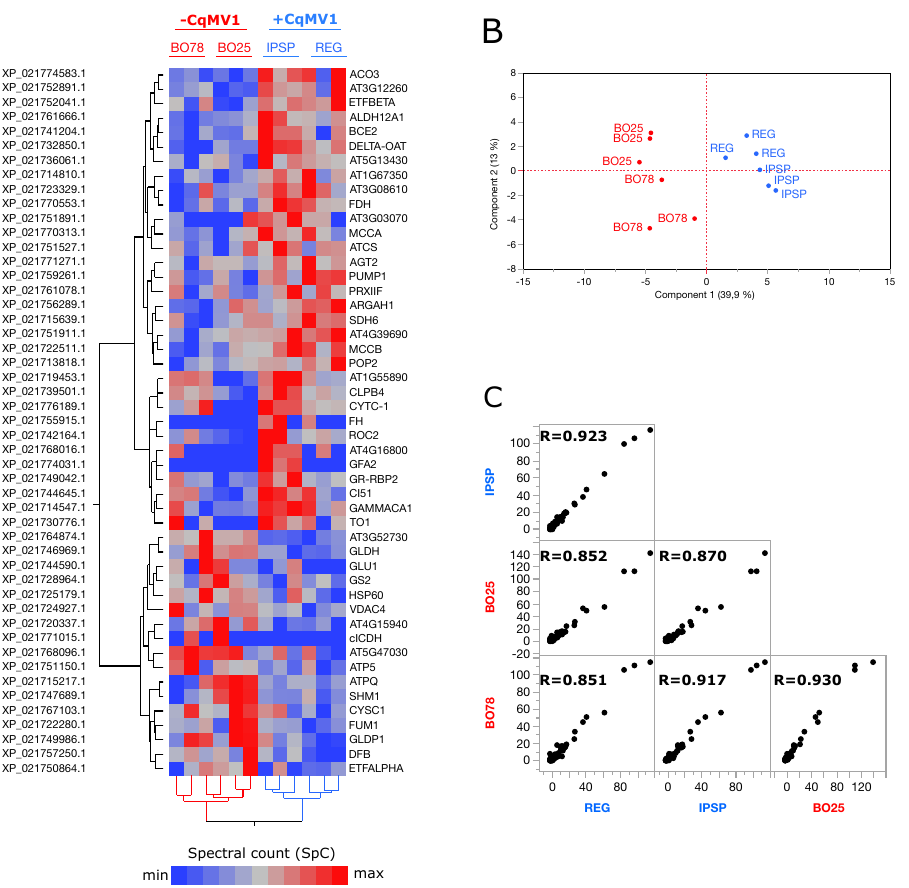
Figure 2. Label-free quantification. ( A ) Hierarchical clustering of differentially expressed mito- chondrial proteins (DEPs) selected by comparing − CqMV1 and +CqMV1 quinoa ( p ≤ 0.05), Ward ’s method and Euclidean distance were used (JMP15.2 SAS software); for each DEP, protein RefSeqs NCBI accession and Arabidopsis thaliana gene name (average homology 73%, min homology 39%, max homology 91%) are shown. ( B ) Principal component analysis and ( C ) Spearman ’s correlation by processing the spectral count (SpC) of